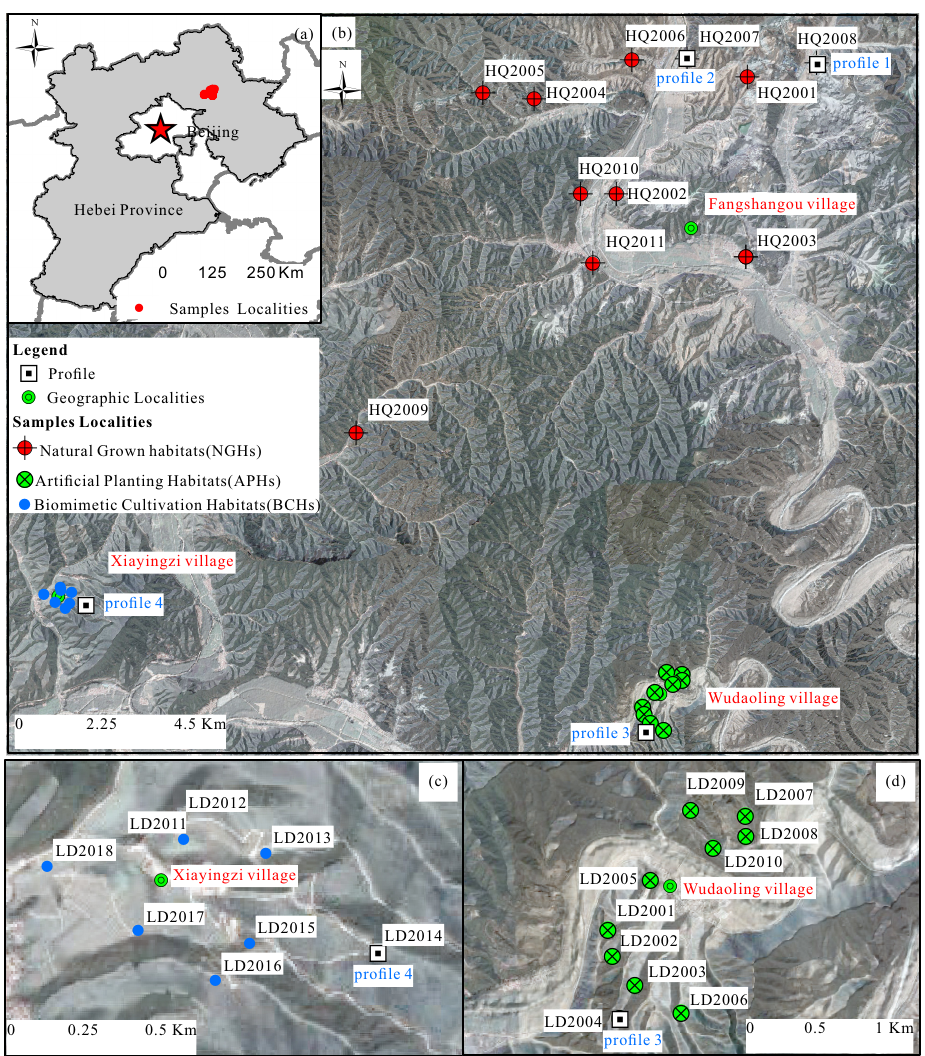
Figure 1. ( a ) Geographical location map; ( b ) Distribution map of sampling in three habitats; ( c ) Distri- bution map of sampling in biomimetic cultivation habitats (BCHs); ( d ) Distribution map of sampling in artificial planting habitats